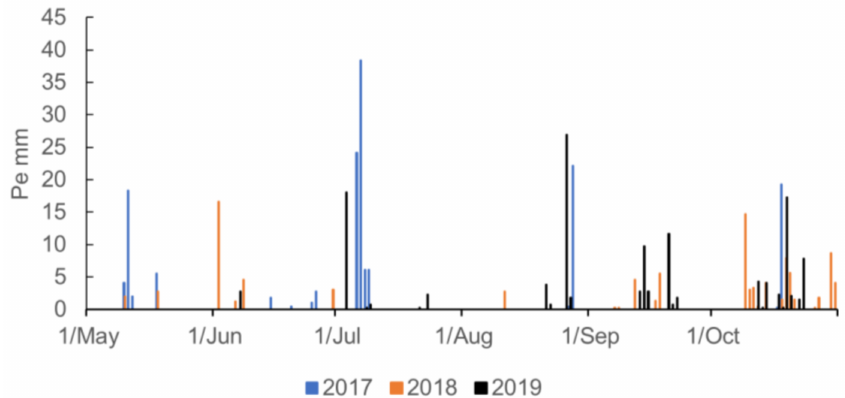
Figure 4. P e values for the irrigation season 2017, 2018,